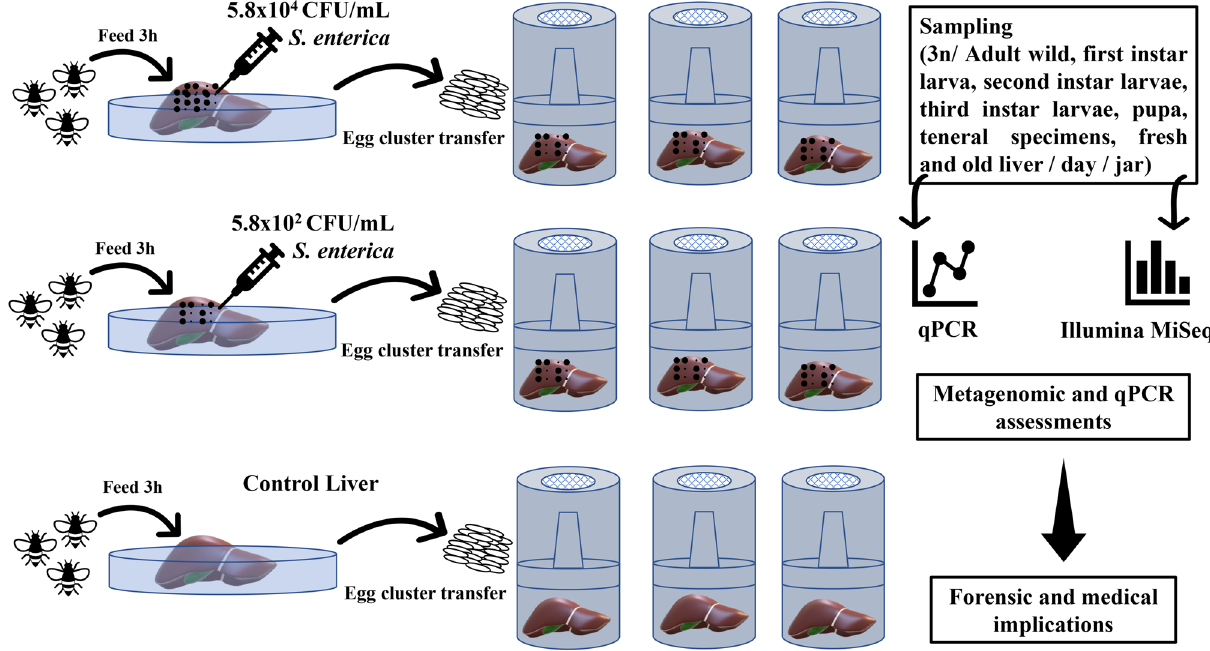
Figure 9. Visual representation of the experimental setup, methods and expected